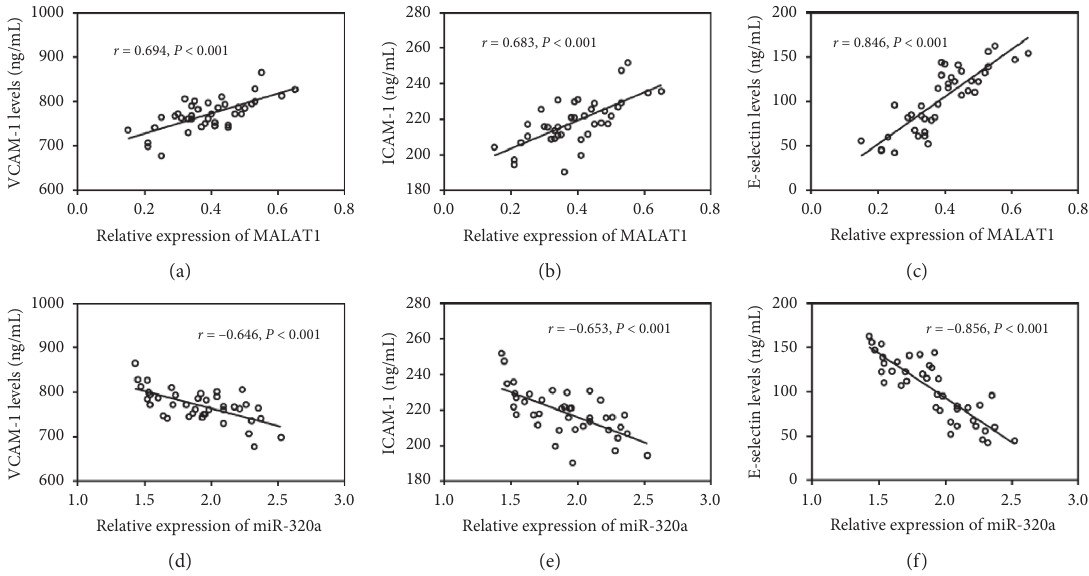
Figure 2: Correlation of MALAT1 and miR-320a levels with the levels of endothelial dysfunction markers. (a)–(c). The expression of MALAT1 was positively correlated with the levels of VCAM-1, ICAM-1, and E-selectin (all P < 0 . 001). (d)–(f). The expression of miR-320a was negatively correlated with the levels of VCAM-1, ICAM-1, and E-selectin (all P < 0 .